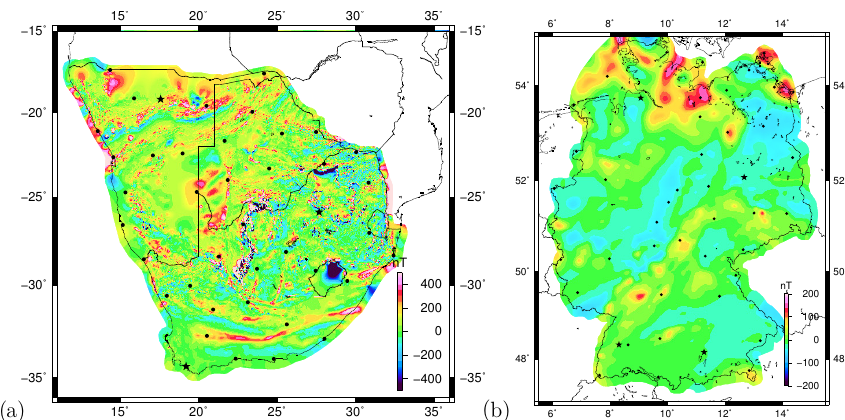
Figure 3. (a) SaNaBoZi grid (M. Hamoudi, personal communication, 2014) scalar field anomalies over the southern African region and (b) scalar field 5 × 5km grid anomaly map by Gabriel et al. (2011) for Germany, both including the locations of the geomagnetic observatories (black stars) and repeat stations (black dots) used in this study. Note regional differences in resolution in the southern African map. Different colour scales are used to accommodate the notable distinction in the maximum intensities of anomalies between the two